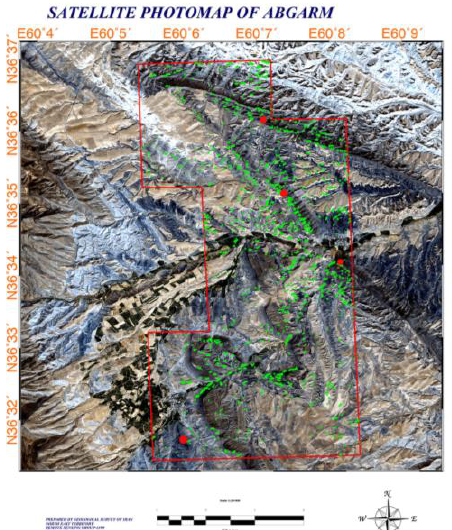
Figure7. SPOT image with Glauconite vectors that derived from SAM method on ASTER